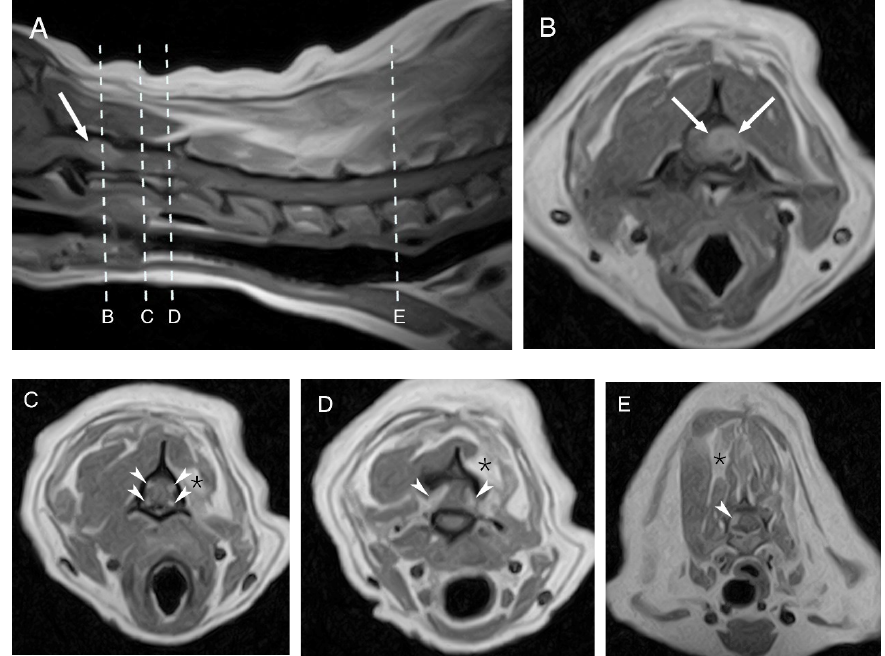
Figure 2. Follow-up MRI of the dog’s cervical region. Midsagittal T1W post contrast image ( A ) and T1W post contrast transverse images at different levels ( B – E ). The arrows are pointing to the largest mass at the level of C1–C2 ( A , B ). The arrowheads are showing the multiple lesions affecting several ventral and dorsal nerve roots bilaterally at the level of C2 ( C ), C2–C3 ( D ) and C6 ( E ). The asterisks show the secondary muscles changes at the level of C2 ( C ), C2–C3 ( D ) and C6 ( E ).